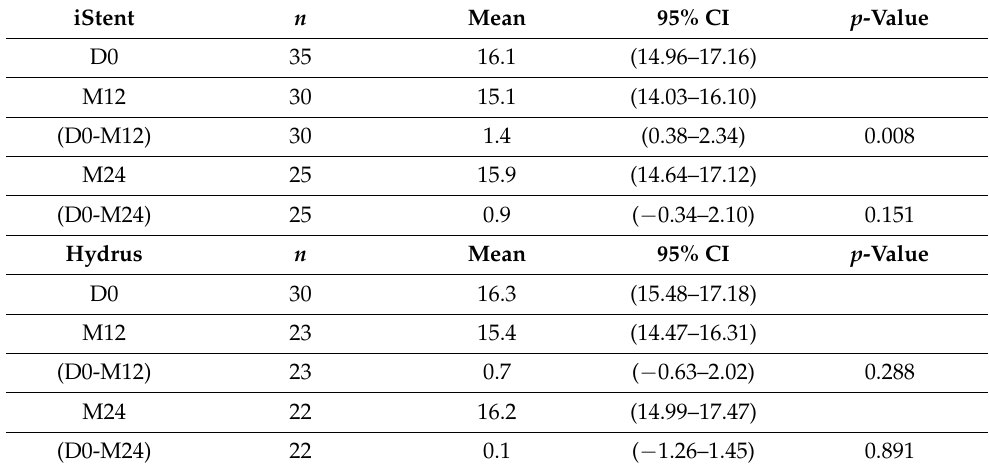
Table 2. Comparison of mean IOP values before surgery vs. values 12 and 24 months after surgery.